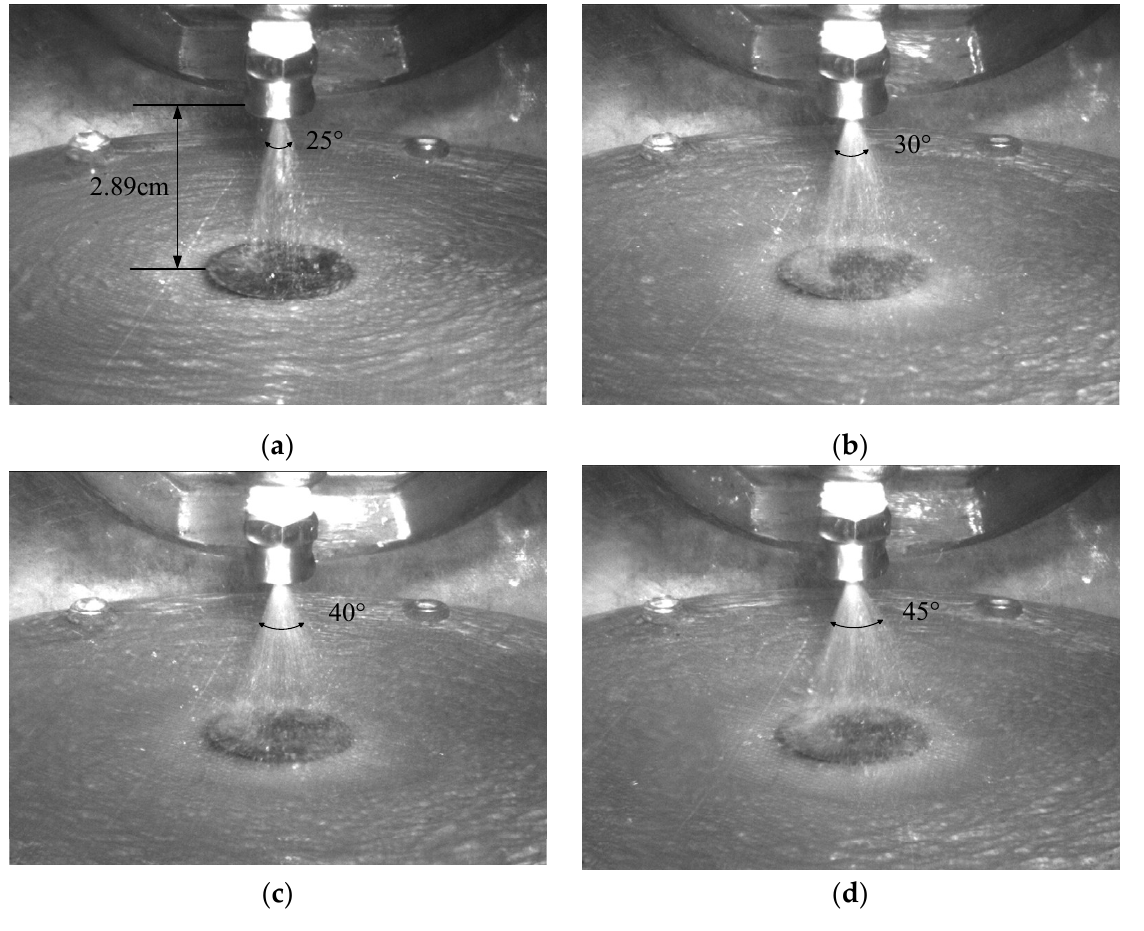
Figure 7. Visualization images of the influence of flow rate change on spray coverage at a heating heat flux of 100 W/cm 2 : ( a ) flow rate 25 L/h; ( b ) flow rate 30 L/h, coverage 42%; ( c ) flow rate 35 L/h, coverage 77%; ( d ) flow rate 45 L/h, coverage 100%.